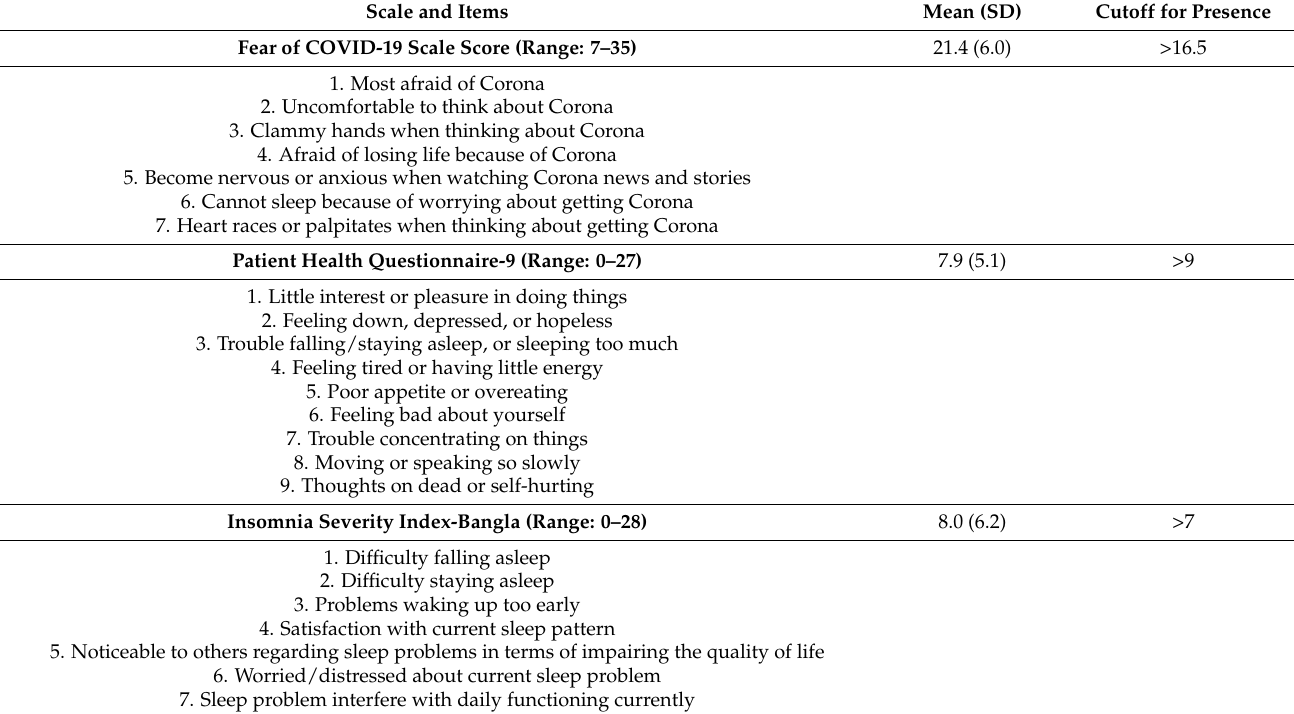
Table 3. Participant characteristics of scale data in the present sample ( n =